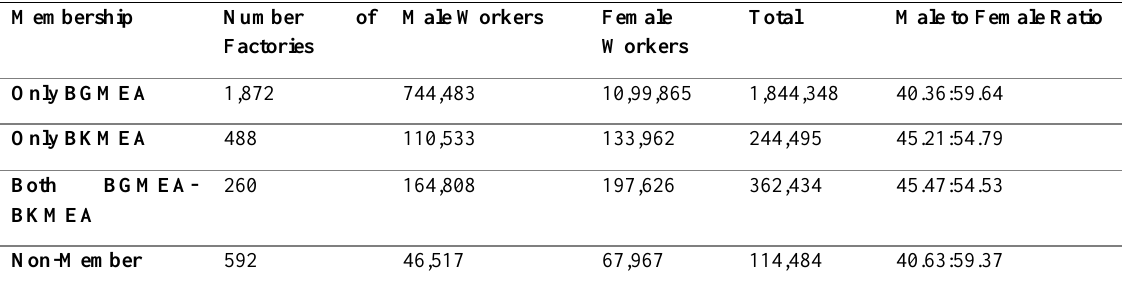
Table 3: Garments Factories and Garments Workers’ Ratio in terms of Trade Association Membership